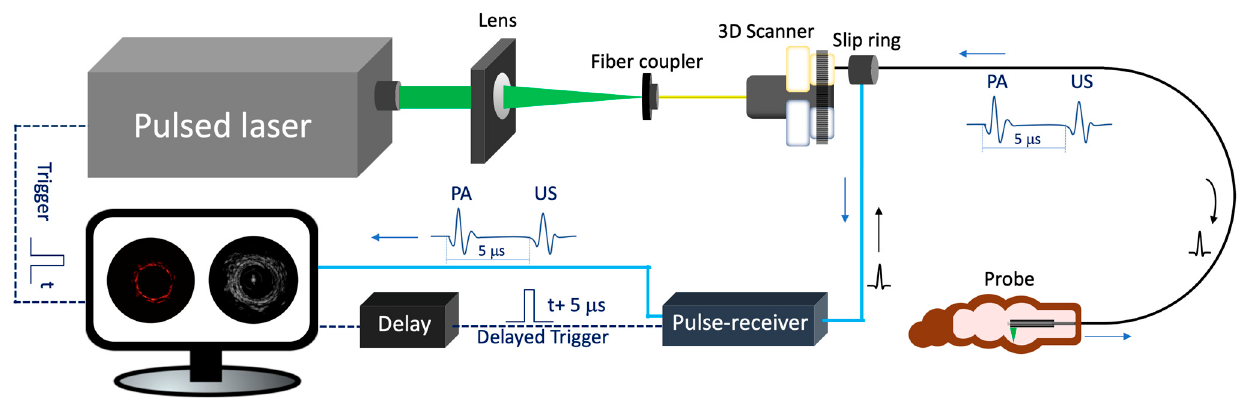
Figure 2. Endoscopic photoacoustic and ultrasound imaging system. PA: photoacoustic. US: ultrasound.